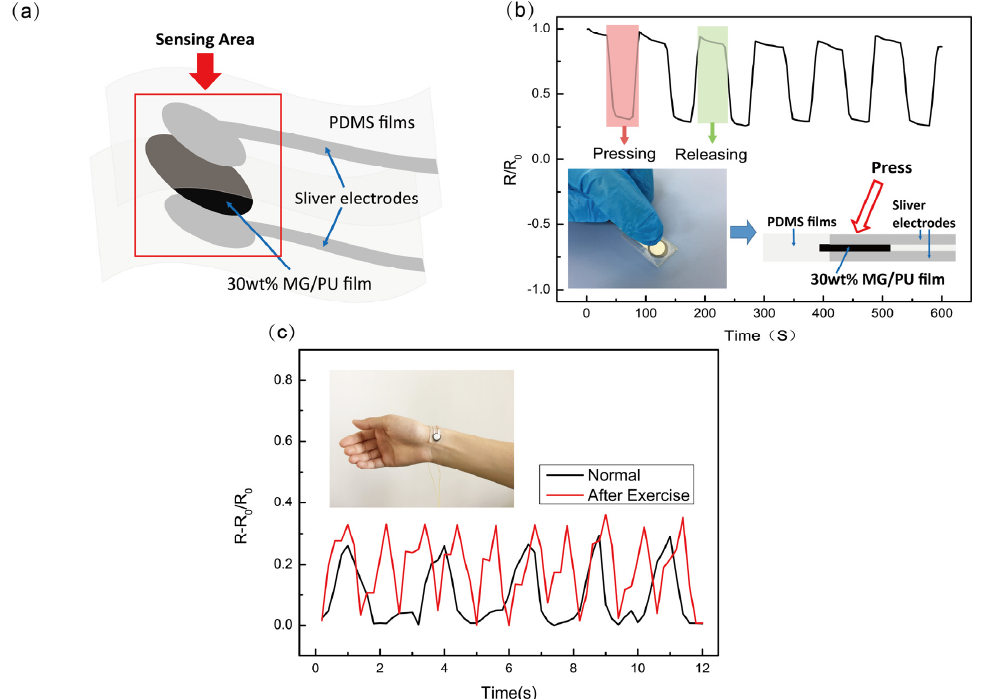
Figure 10. Detection of the resistance responses to dynamic loading and unloading cycles. ( a ) Schematic of the flexible piezoresistive sensor; ( b ) pressing; ( c ) piezoresistive response of the sensor wrapped around the wrist before and after exercise.